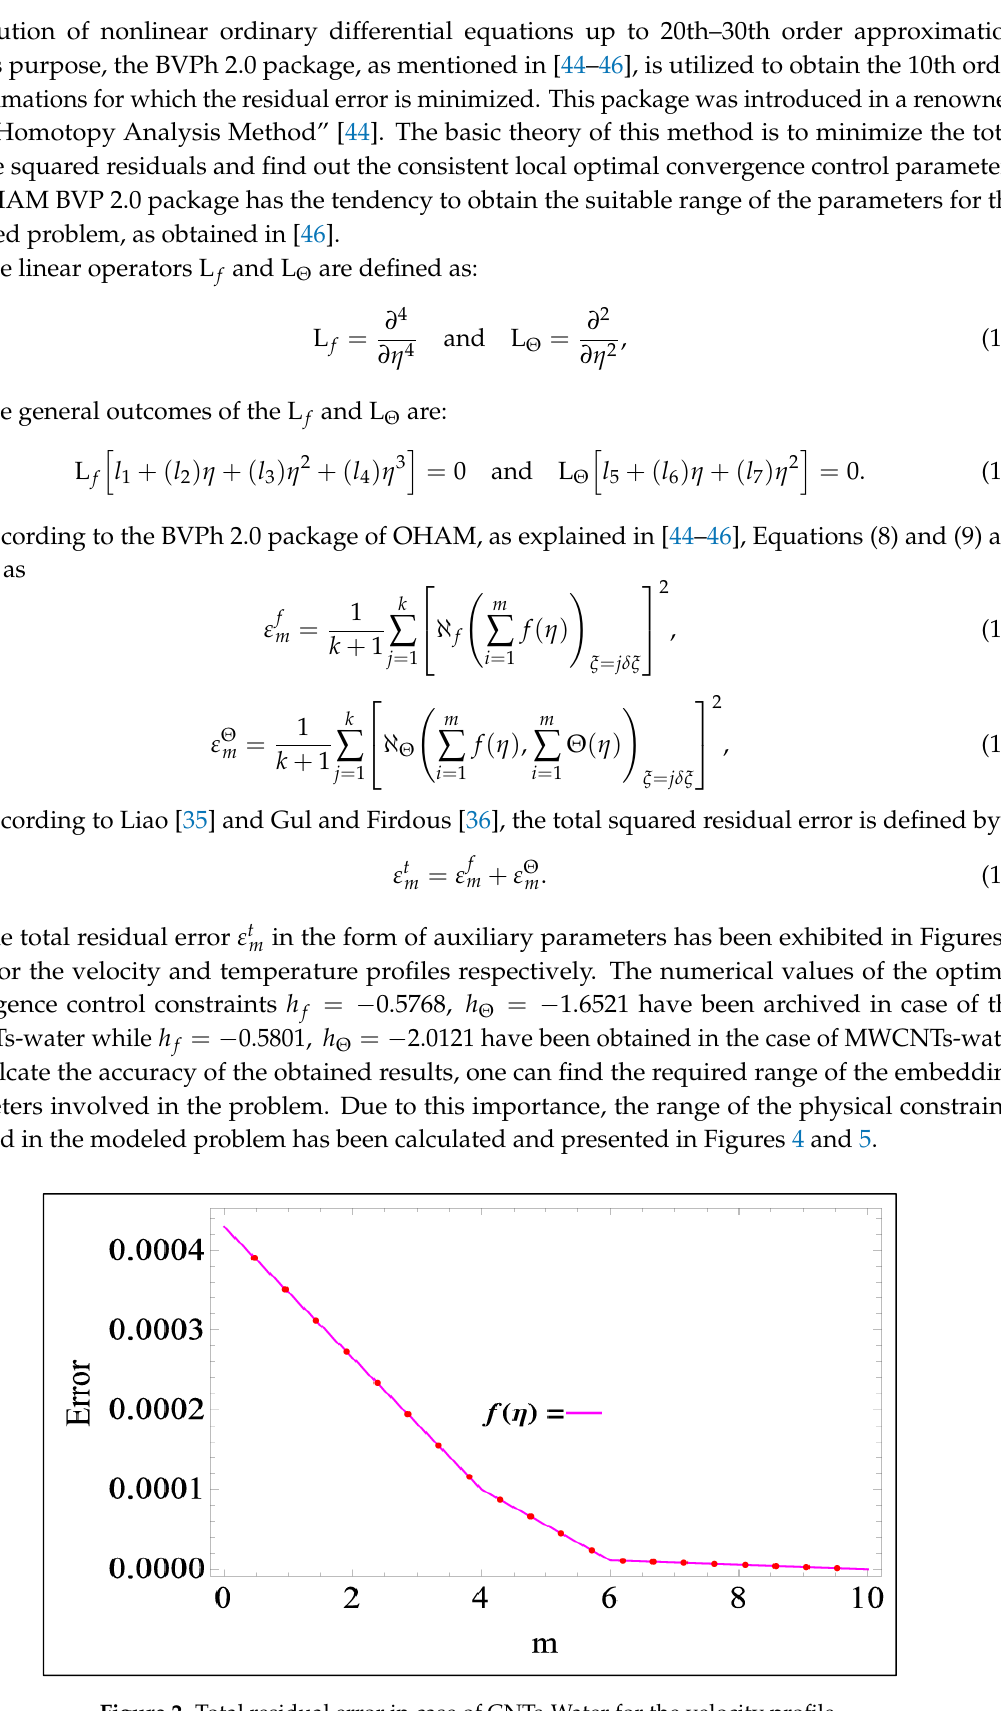
Figure 2. Total residual error in case of CNTs-Water for the velocity profile.